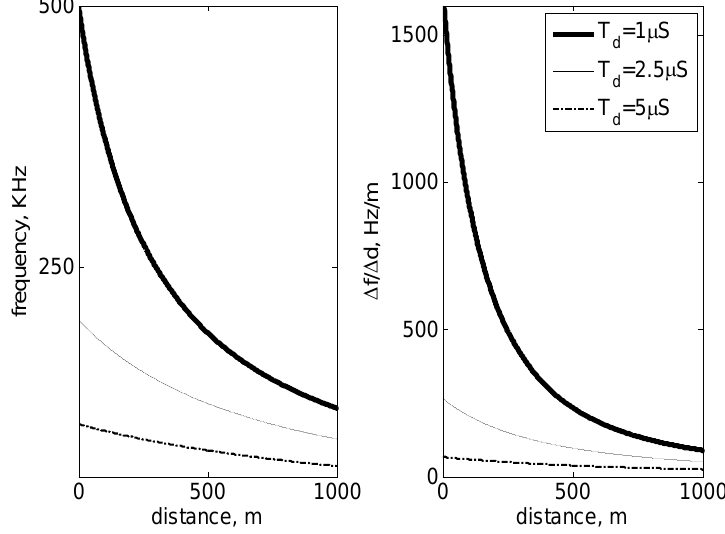
Figure 2. Frequency detected versus distance measured left, sensitivity as Δ f/ Δ d versus distance right.